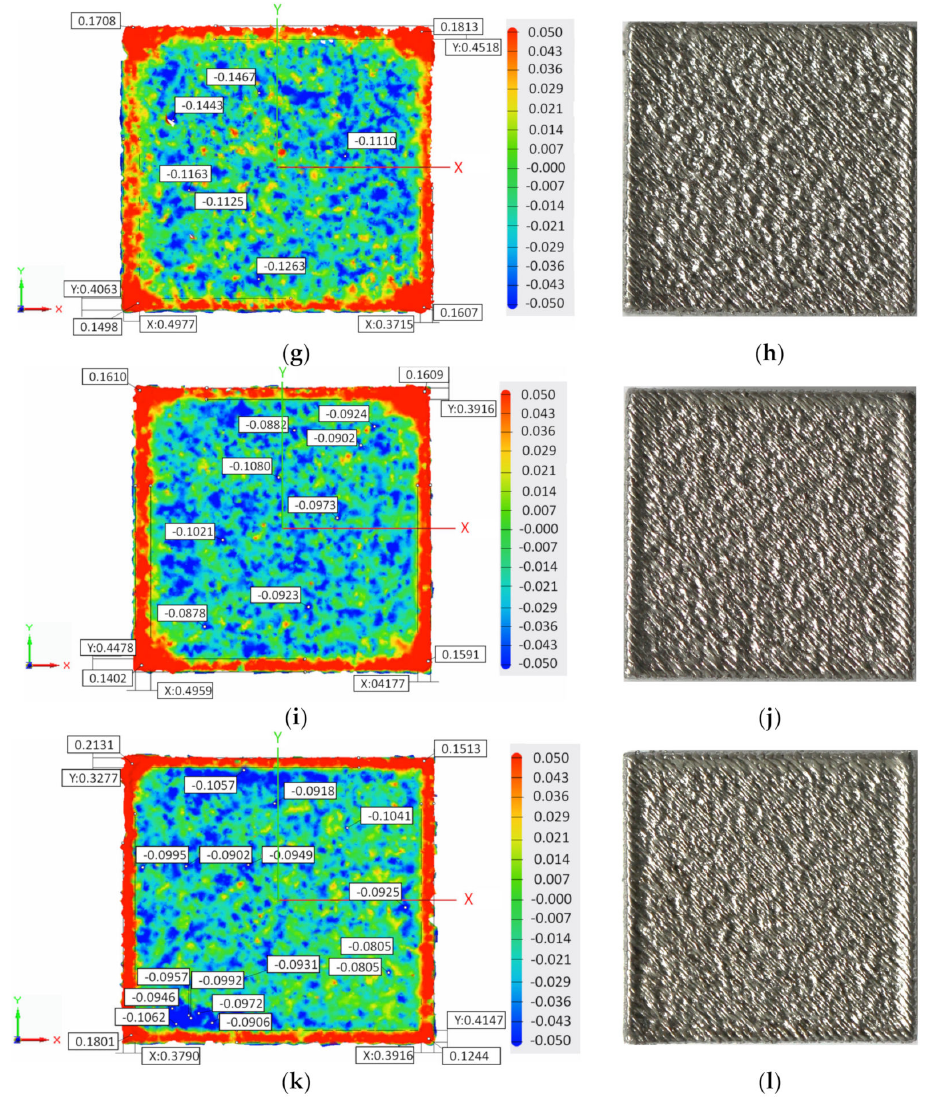
Figure 8. Topography and macroscopic top surface views of the samples built with a 45 ◦ hatch angle rotation, using standard VED (76 J/mm 3 ) and lower VED (63 J/mm 3 ) for melting the last layer(s): ( a , b ) standard VED for the last layer, ( c , d ) lower VED for the last layer, ( e , f ) lower VED for the last two layers, ( g , h ) lower VED for the last three layers, ( i , j ) lower VED for the last five layers, and ( k , l ) lower VED for the last ten